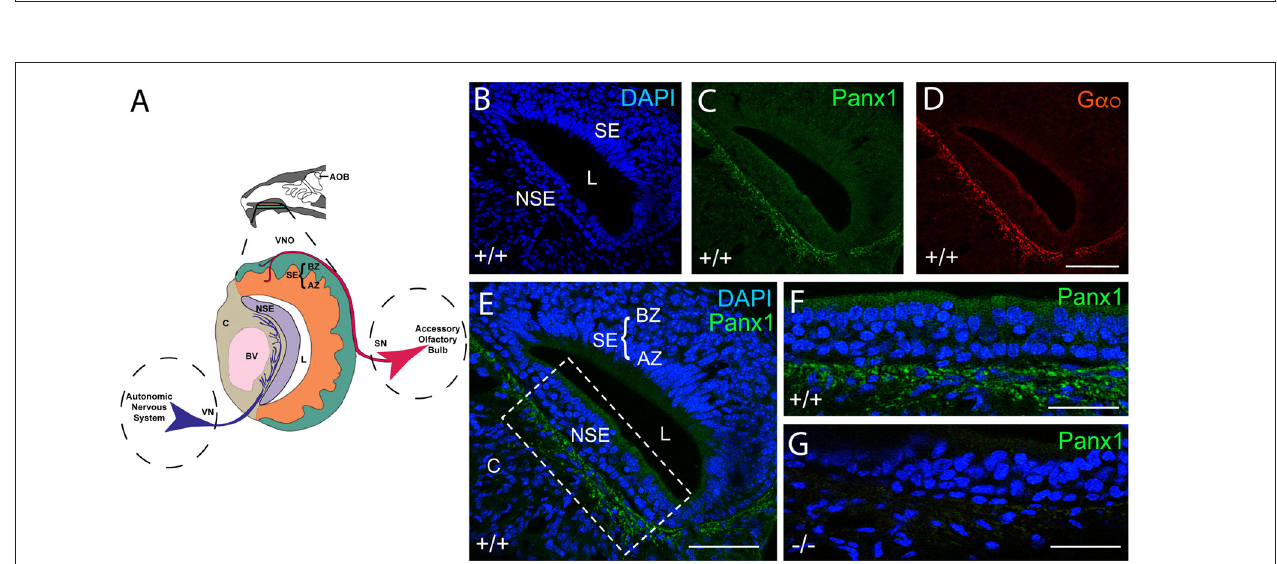
FIGURE 2 | Panx1 protein expression in the NSE of the juvenile mouse VNO. (A) Overview of the murine VNO adapted from Sánchez-Andrade and Logan (2014) (B–D) . The intact wild-type VNO imaged at 40 × magnification is shown in (B) depicting DAPI staining of nuclei, the localization of (C) mPanx1 and (D) of the G-alpha protein G α o. The region highlighted by the box in the overview in (E) is shown at 63 × magnification in (F) highlighting the significant mPanx1 expression in the basal and lower expression in the ciliated epithelium of the NSE. (G) A comparable region in Panx1 − / − mice lacked Panx1 expression. Abbreviations: AZ, apical zone; BZ, basal zone; SE, sensory epithelium; L, lumen; NSE, non-sensory epithelium; C, cavernous tissue; BV, a blood vessel. Scale bars: (B–E) = 100 µ m, (F,G) = 50 µ